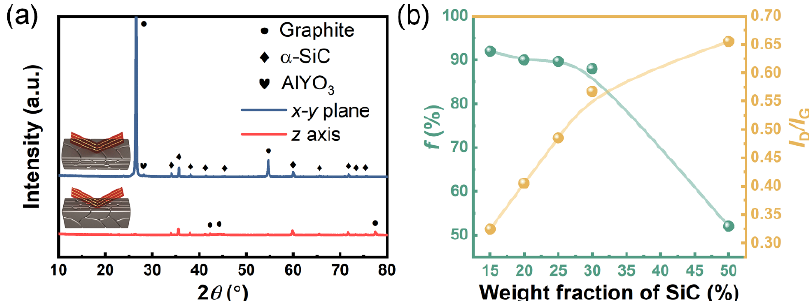
Fig. 3 (a) XRD patterns of SiC30/GF composite in two principle directions. (b) Lotgering factor f values of (002) plane and the intensity ratios of D to G peaks ( I D / I G ) of graphite in SiC/GF